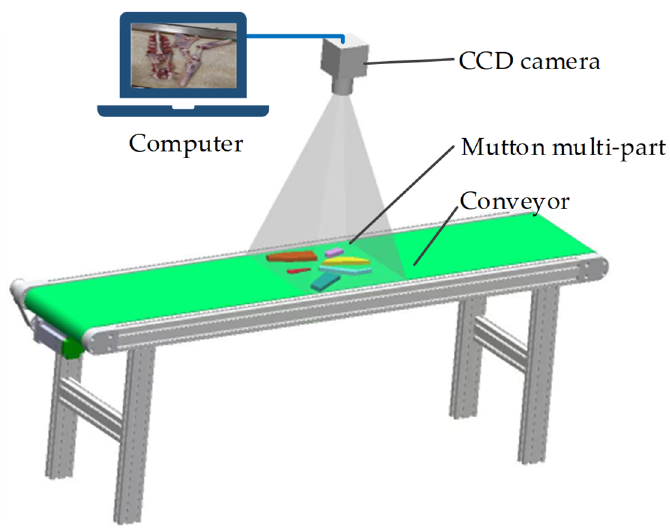
Figure 1. Mutton multi-part images acquisition device.